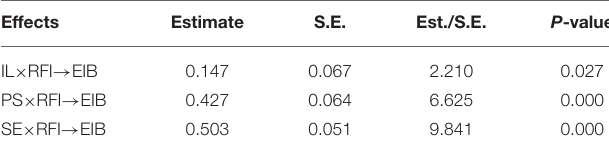
TABLE 4 | Results of moderating effect test.